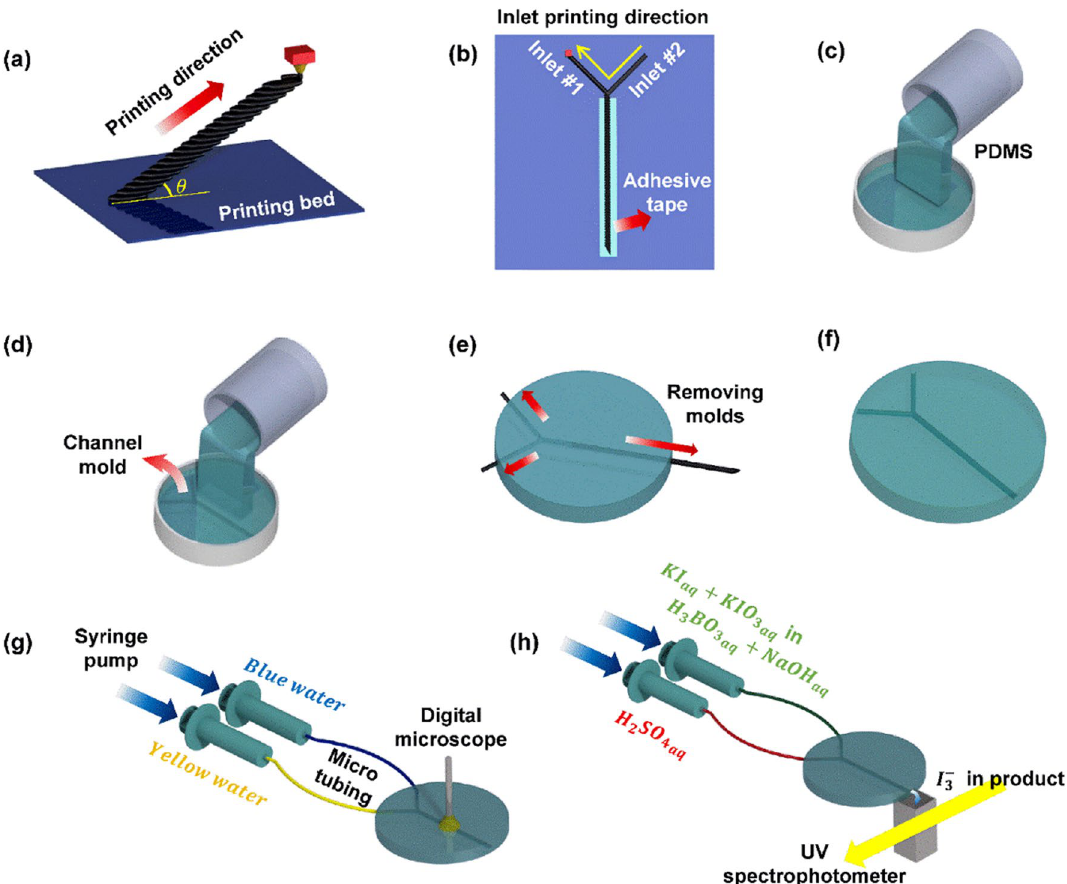
Figure 2. Fabrication and experimental process of a micromixer: ( a ) Printing mixing channel molds, ( b ) overlap printing for inlet channel, ( c ) first PDMS curing, ( d ) second PDMS curing, ( e ) removing each channel mold from cured PDMS molds, and ( f ) finalizing mixer channels. ( g ) Colorimetric experiment and ( h ) experiment for iodide–iodate competitive parallel reaction to investigate the mixing efficiency quantitatively.